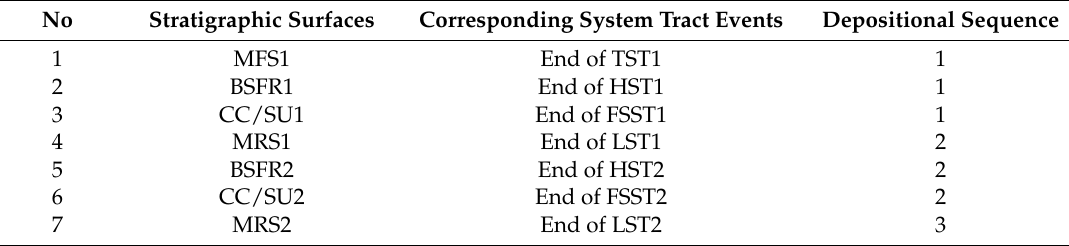
Table 2. Stratigraphic surfaces with their corresponding events and depositional